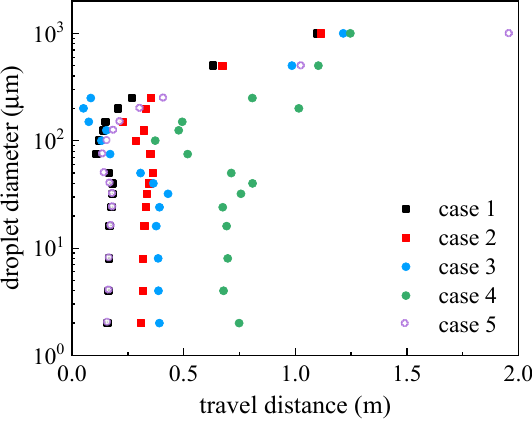
Figure 9. Travel distance of droplets with different diameters in the x -direction at time t = 1 s.